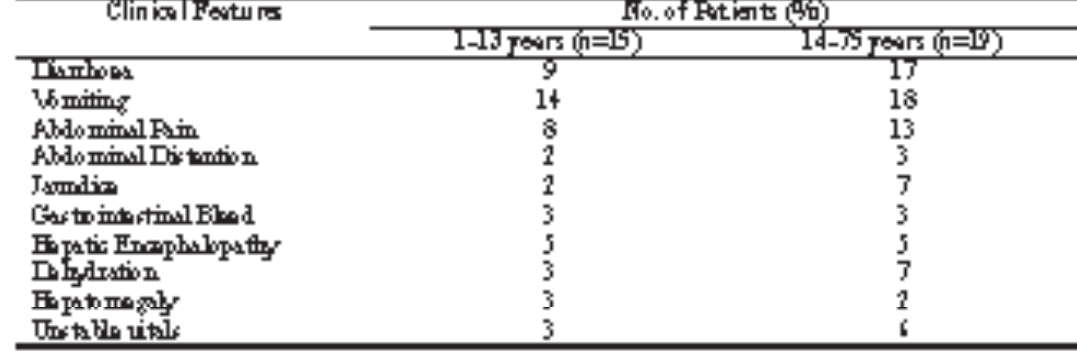
Table II: Clinical features of the cases admitted with the diagnosis